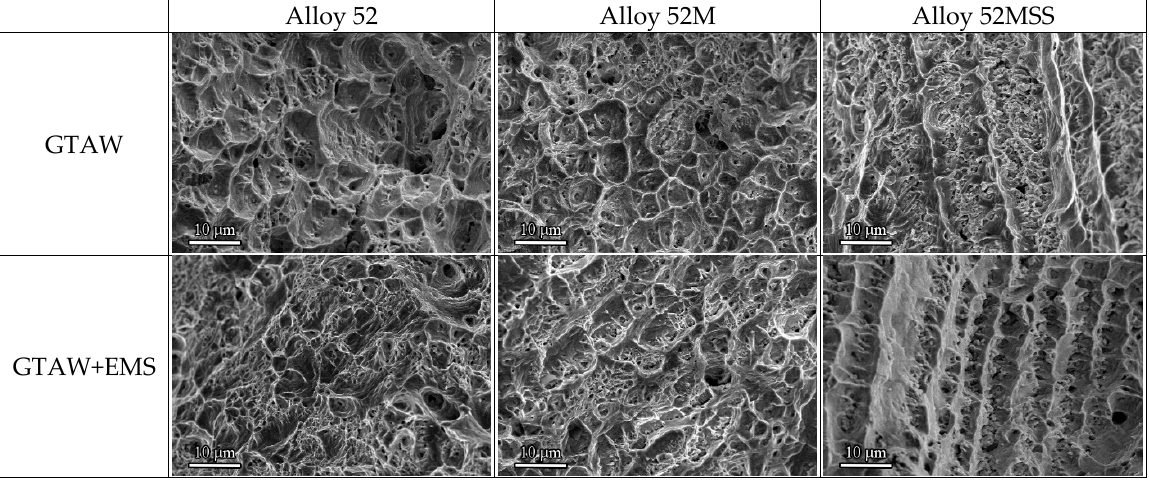
Figure 17. Fractographs of tensile specimens.